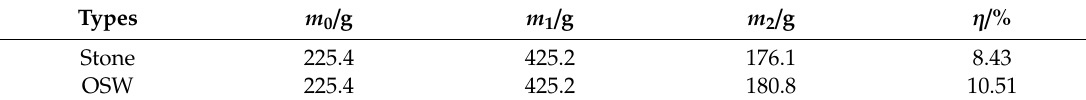
Table 8. Asphalt adsorption capacity test results of OSW and stone.